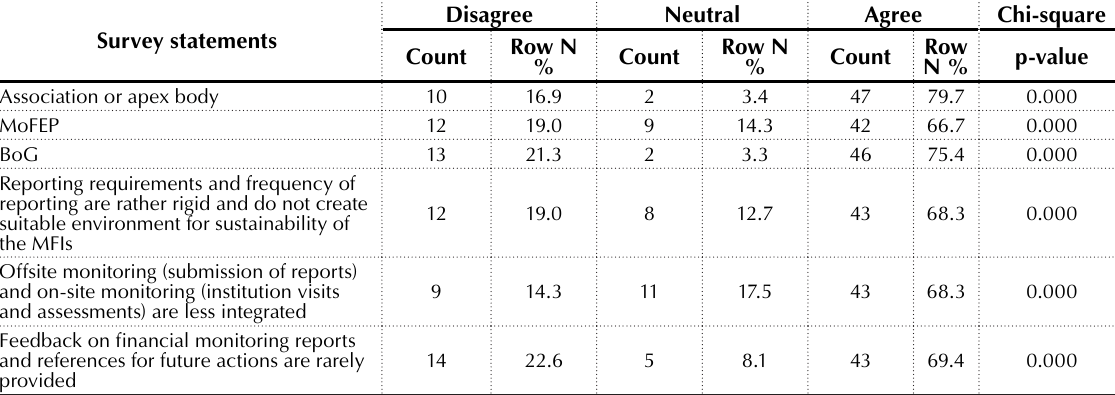
Table 5 (cont.). Implementation, monitoring and supervision